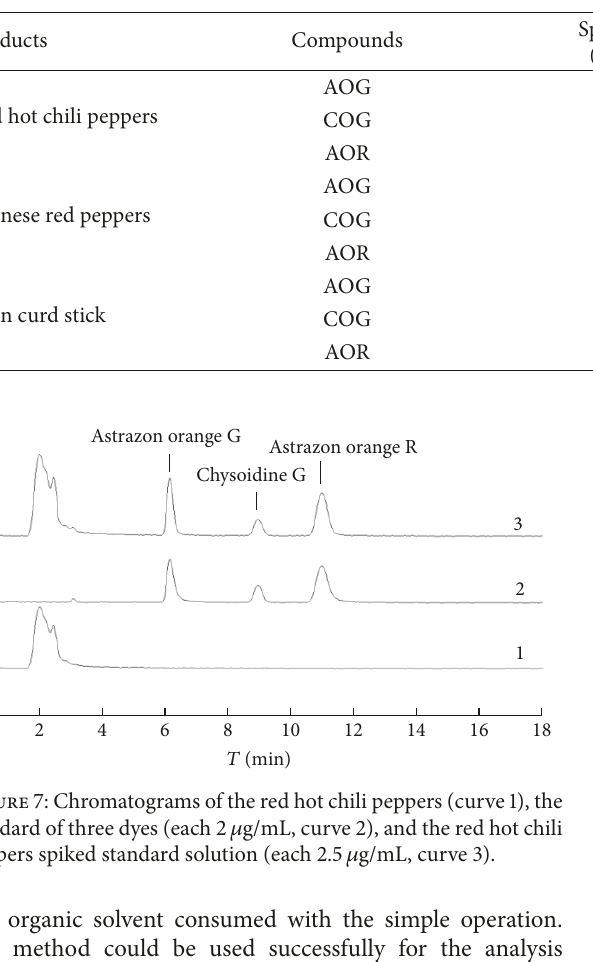
Table 3: Recoveries of the dyes in different food samples with this method ( 𝑛 = 3 ).